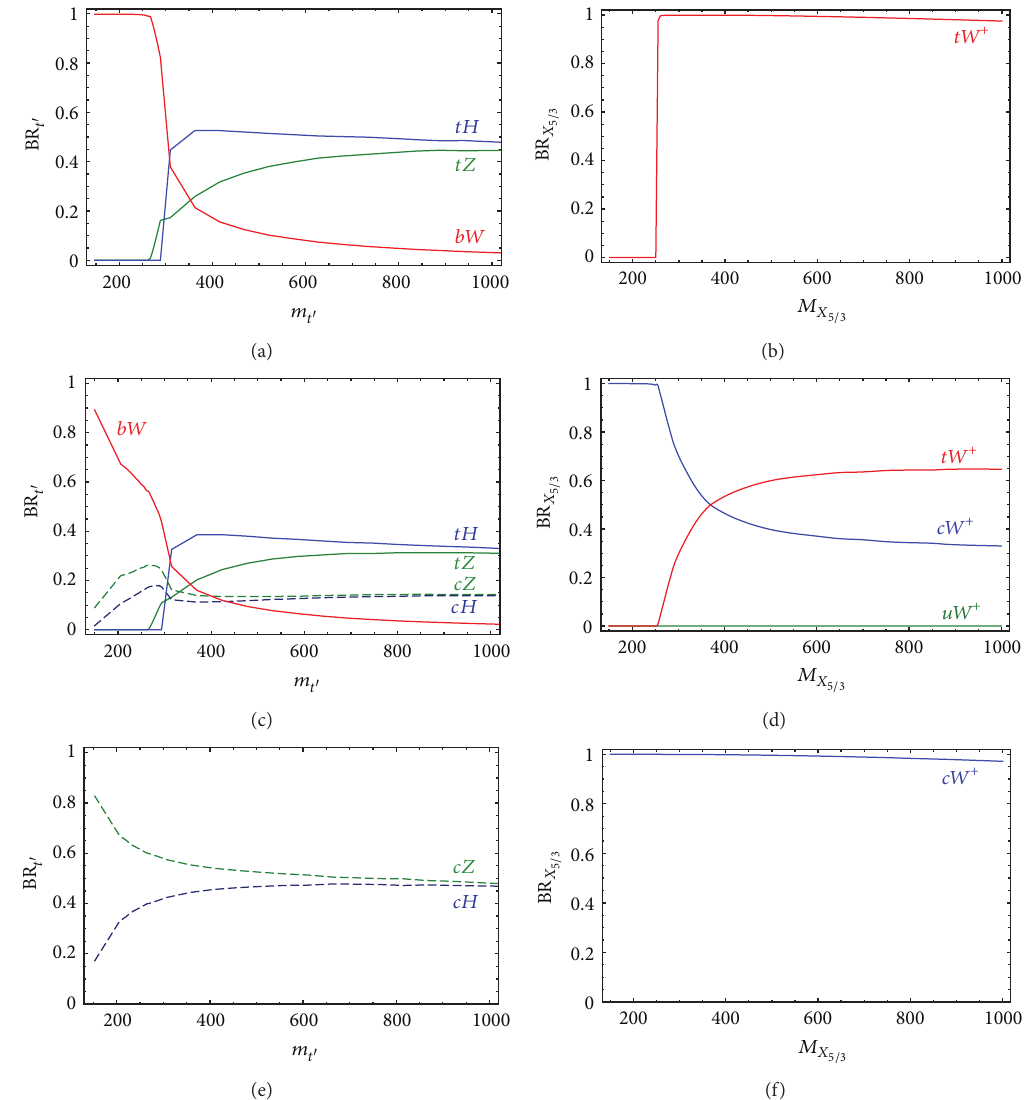
Figure 7: Branching ratios for 𝑡 󸀠 (first column) and 𝑋 5/3 (second column) belonging to the non-SM doublet (𝑋 5/3 ,𝑡 󸀠 ) for different mixing hypotheses. From top to bottom: mixing only with top; mixing with top and charm; mixing only with charm. The mixing parameters have been saturated according to the bounds obtained in [35]. Notice that the BR of 𝑋 5/3 in the case of mixing only with top or charm is not identically 1: this is due to the presence of three-body decays, which have not been included in the plot. 𝑍𝑡 , 𝑡ℎ , or 𝑊𝑏 . Depending on the considered Higgs mass (125 or > 200 Gev), Higgs decays ℎ → 𝛾𝛾 or ℎ → 𝑍𝑍 → 4𝑙